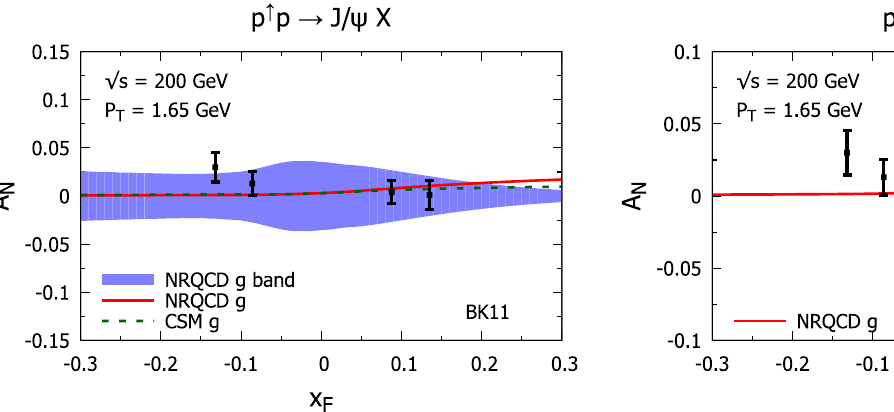
Fig. 3 Maximized values for A N for the process p ↑ p → J /ψ X as a √ s = 200 GeV and P T = 1 . 65 GeV, for the gluon function of x F at Sivers effect both in the CSM (green dashed lines) and in NRQCD (red solid lines), and for the quark Sivers effect (blue dotted line), adopting